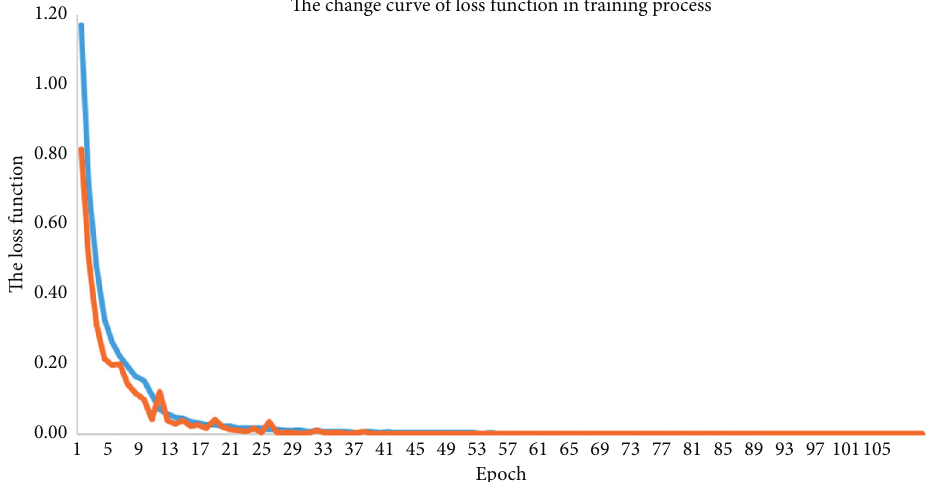
Figure 10: The loss function of bearing dataset experiment. change curve of loss function in training process 1.20